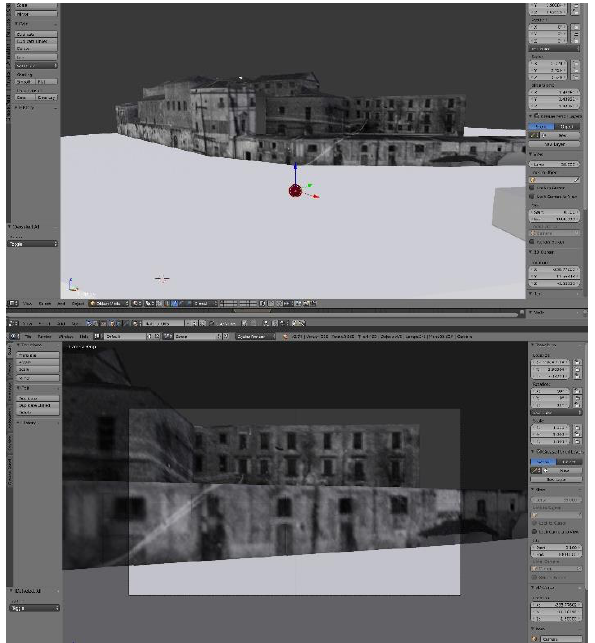
Figure 15: Orientation of the virtual panoramic image.